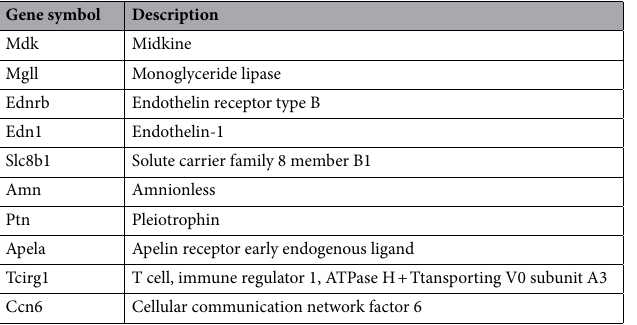
Table 1. Genes related to the excretion GO term and upregulated by NMDA injection and downregulated by KUS121 and KUS187